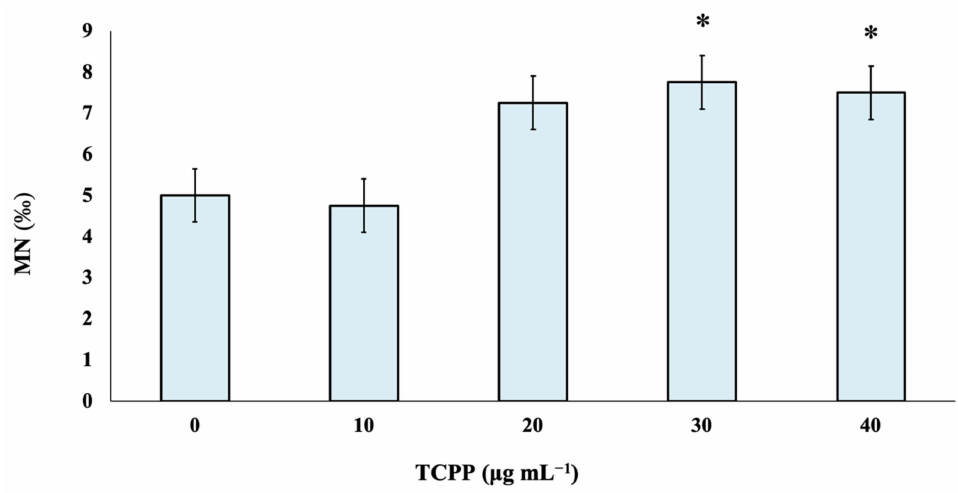
Figure 1. Genotoxic effects of TCPP in human lymphocytes. MN frequencies are expressed as mean frequencies (‰) ± standard error. * p < 0.05 (significant differences compared to the control value, G-test). The cytotoxic effect of TCPP was evaluated by the determination of the CBPI index.